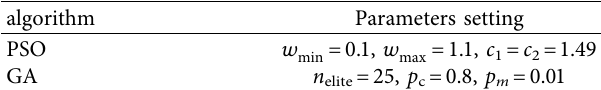
Figure 5: Mesh graphic of four benchmark functions ( D � 2):(a) Sphere function( F (d) Rosenbrock’s valley function( F 4 ). Table 1: Other parameters setting of GA and PSO. algorithm Parameters